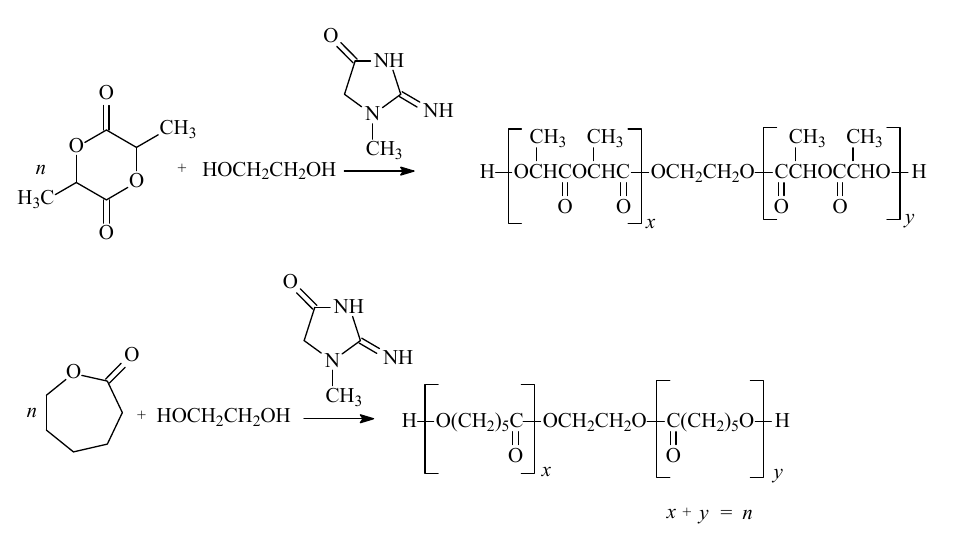
Table 1. The homopolymerization of CL, LA and D-LA, initiated by CE. Run